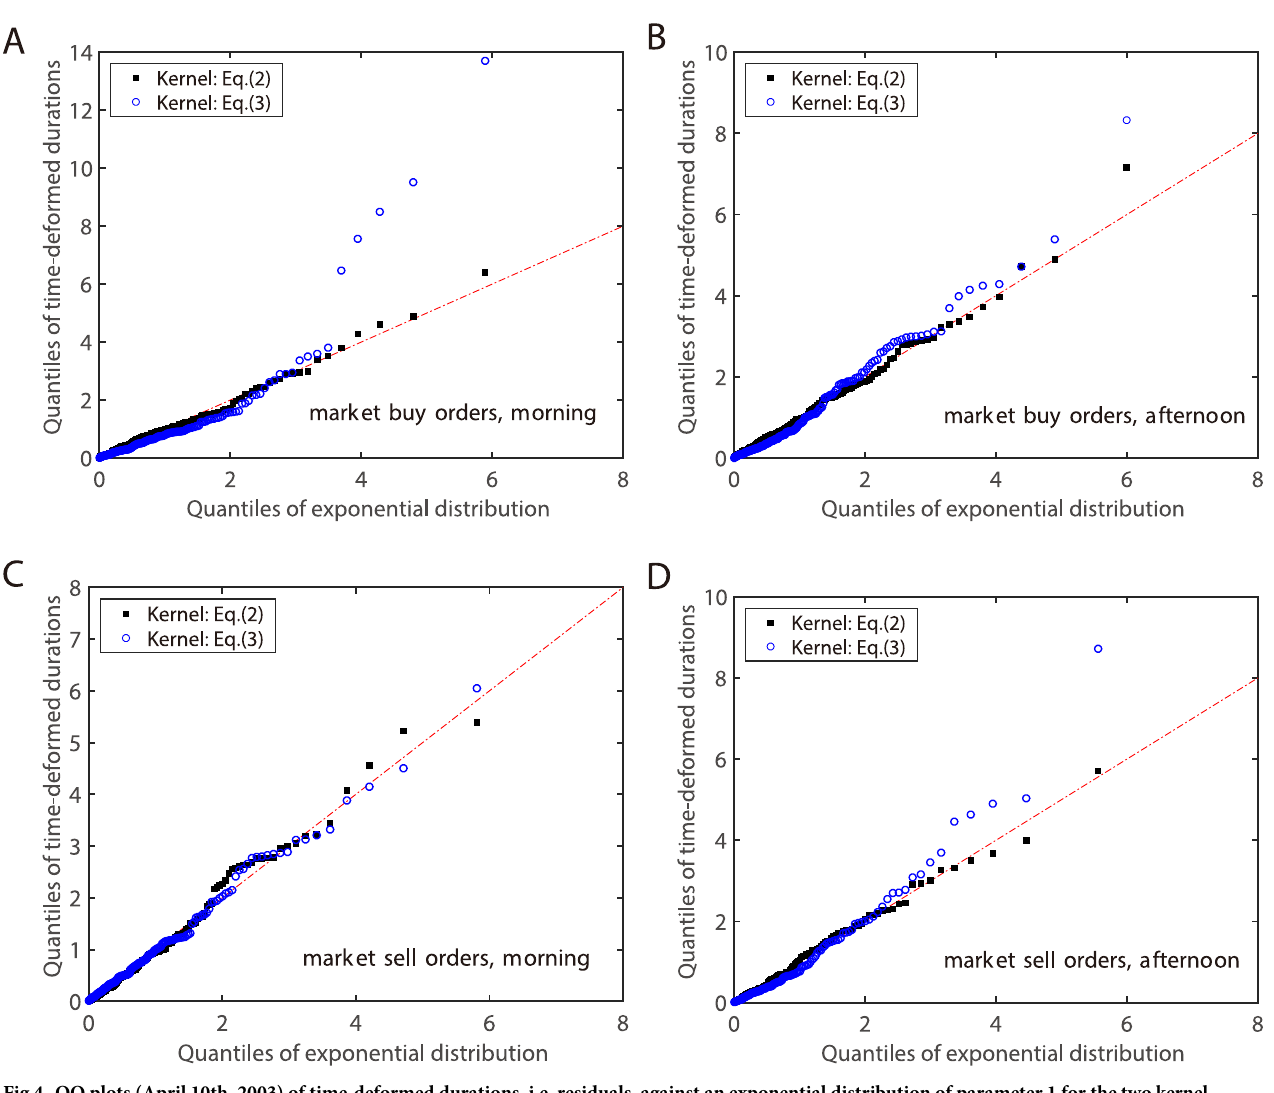
Fig 4. QQ plots (April 10th, 2003) of time-deformed durations, i.e. residuals, against an exponential distribution of parameter 1 for the two kernel functions in Eqs (2) and (3). A: aggressive market buy orders in the morning. B: aggressive market buy orders in the afternoon. C: aggressive market sell orders in the morning. D: aggressive market sell orders in the